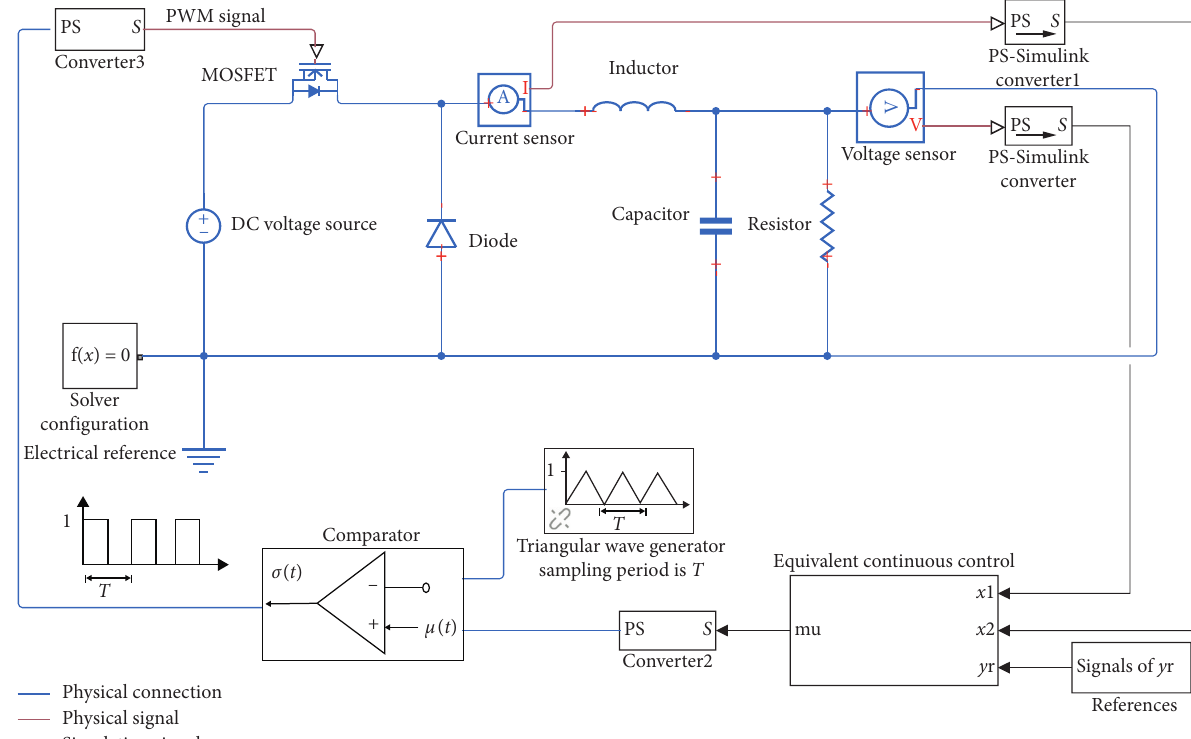
Figure 5: The control framework of buck converters under PWM-based finite-time tracking